Question: Provide a one-line summary of what is displayed.
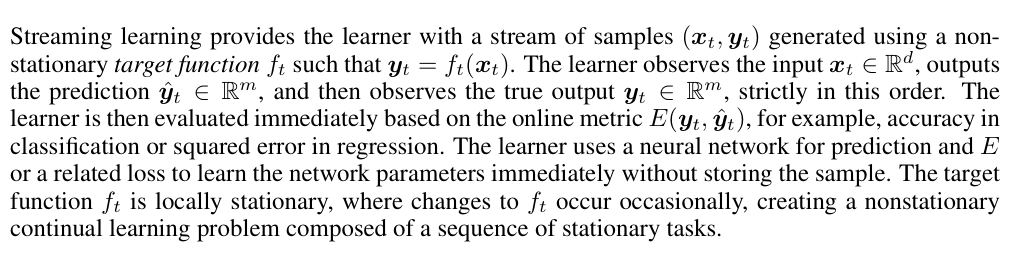
Answer: (a) illustrates catastrophic forgetting with Adam in the streaming learning setting. Here, a sequence of tasks based on Label-Permuted EMNIST is presented to the learner. The tasks are de- signed to be highly coherent, where the features learned in one task are fully reusable in the other. Full details of the problem are described in Section 4.4. If the learner can remember and leverage prior learning, it should continue to improve performance as more tasks are presented. However, Fig. 1(a) reveals that Adam can hardly improve its performance, which remains at a low level of ac- curacy, indicating forgetting and relearning. Although catastrophic forgetting is commonly studied under offline evaluation (solid lines), the issue also manifests in online evaluation (dashed lines). This result indicates that current representation learning methods are unable to leverage previously learned useful features but instead forget and relearn them in subsequent tasks.